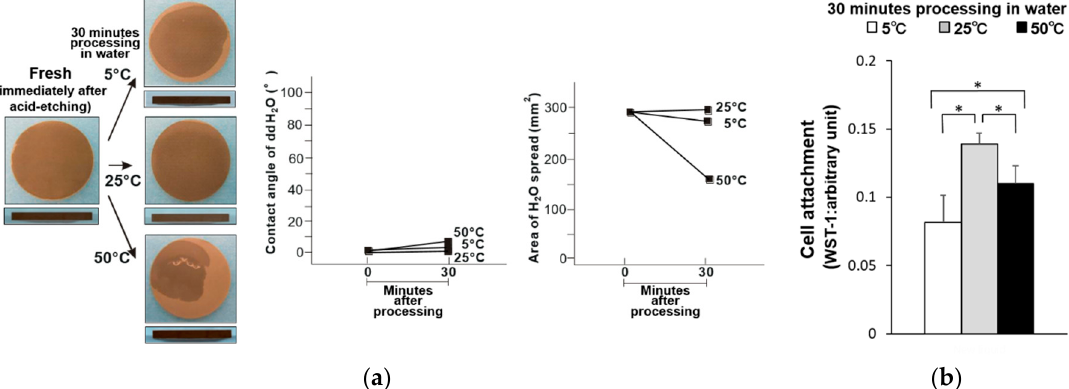
Figure 4. ( a ) Hydrophobicity/hydrophilicity of the fresh–wet titanium disk surfaces illustrated as a photograph of 10 µL ddH 2 O placed on the sample surface before and after temperature deviation (left) with the corresponding contact angle (middle) and spread area (right). ( b ) Initial attachment of osteoblasts to the fresh–wet titanium disk surfaces. * p < 0.05, statistically significant difference.